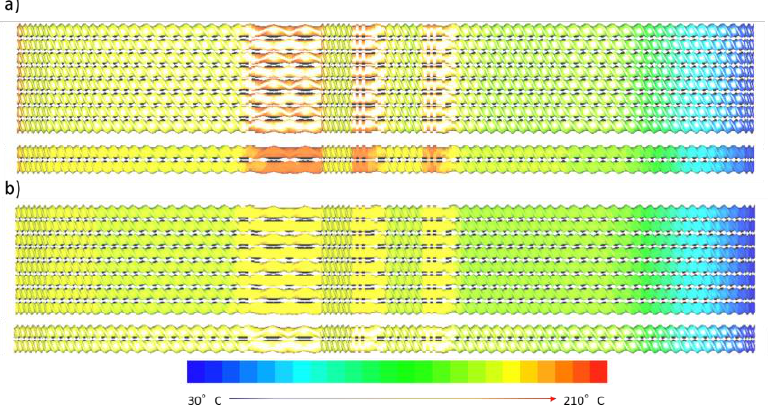
Figure 9. Calculated temperature distribution in octa- and twin-screw extruders operated at Q/N ratios of ( a ) 0.00365 and ( b ) 0.0073.